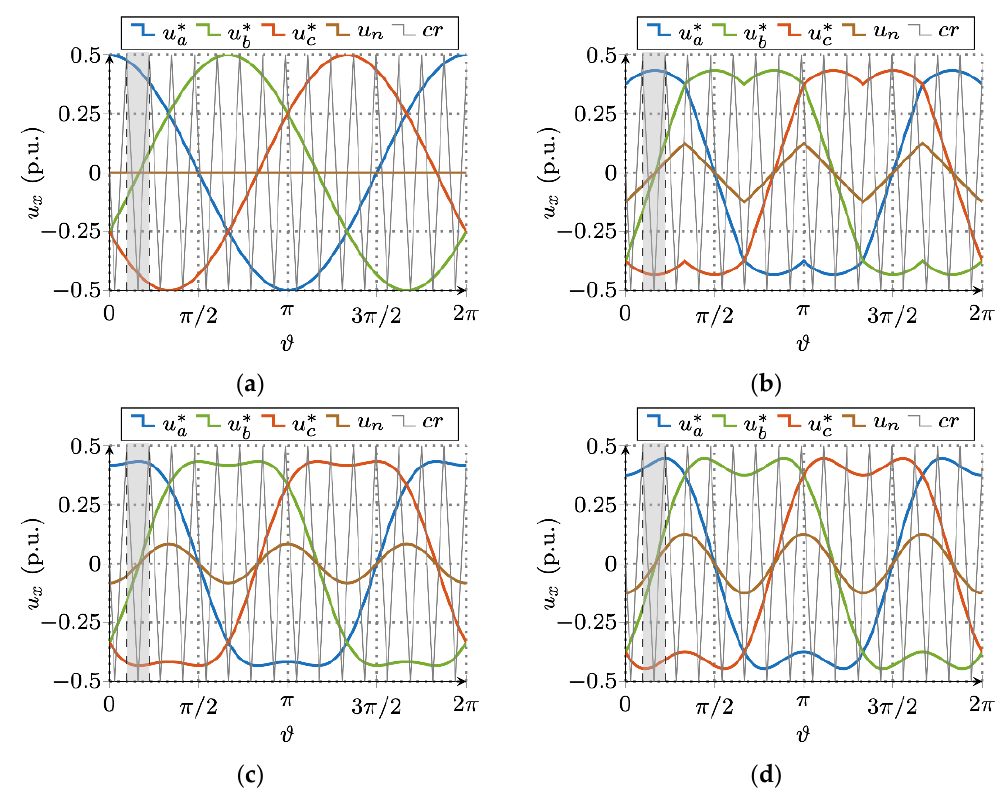
Figure 2. Phase ( u * ) and neutral ( u n ) modulating signals (at m = 0.5) of: ( a ) SPWM; ( b ) CPWM; ( c ) THIPWM1/6; and ( d ) THIPWM1/4. ( c ) THIPWM1 / 6; and ( d ) THIPWM1 /